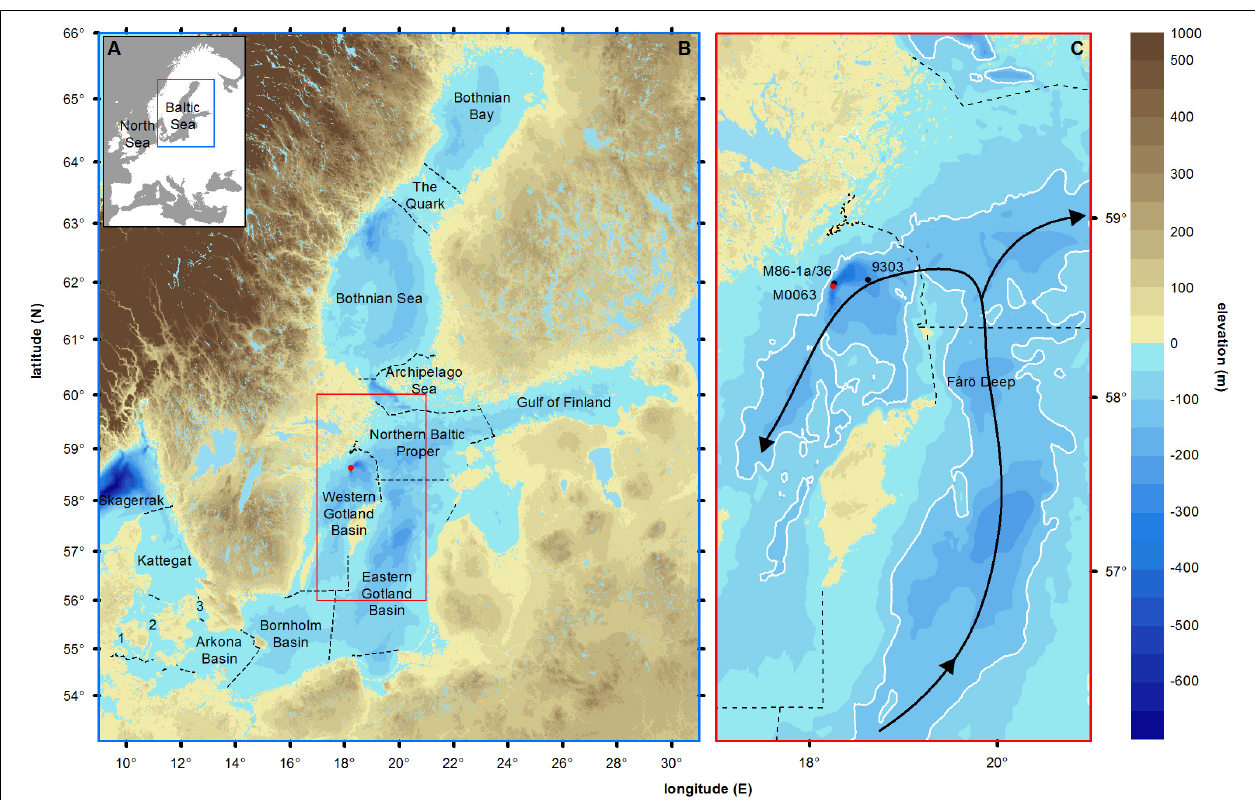
FIGURE 1 | (A) Map of Europe showing the semi-enclosed position of the Baltic Sea. (B) Land elevation (brown shades, meters), bathymetry (blue shades, meters) and main sub-basins of the Baltic Sea (dotted lines, according to HELCOM). Skagerrak and Kattegat form the transition zone to the North Sea. The Little Belt (1), Great Belt (2), and Öresund (3) form the connections to the North Sea. The Arkona Basin, Bornholm Basin, Eastern Gotland Basin, Northern Baltic Proper and Western Gotland Basin form the Baltic Proper. The Bothnian Sea, The Quark and the Bothnian Bay form the Gulf of Bothnia. (C) Inset of the studied area. The red dot represents the studied Integrated Ocean Drilling Program Expedition 347 site M0063 (Landsort Deep, 58 ◦ 37.350’N, 18 ◦ 15.260’E, Andrén et al., 2015). The black dots represent the sites 435-2 (Warden et al., 2017) and 9303 (Bianchi et al., 2000), used for comparison of carbon data and corresponding ages to data of core M0063D. White lines indicate 100 m depth contours. Black arrows show the directions of inflowing deep-water. Geospatial data are provided by HELCOMs Map and Database Service